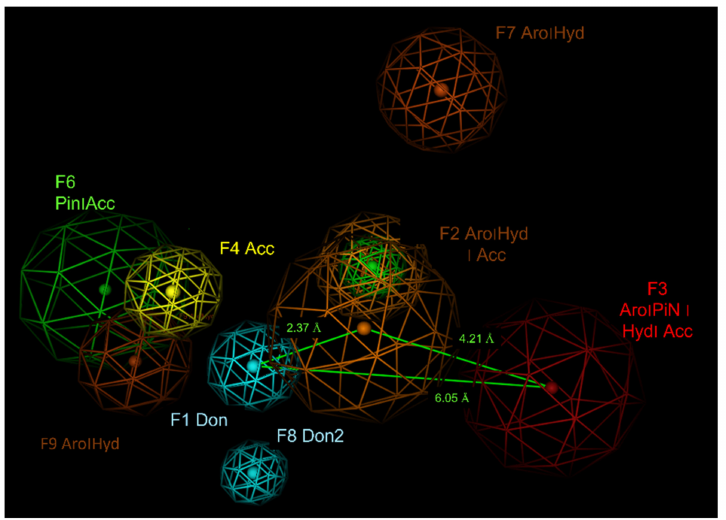
Figure 12. The main pharmacophore requirements experienced by hybrids are reported along with their related distances, focusing on F1–F3 groups. H-bonding groups are named as F Acc and F Don while aromatic features are reported as F